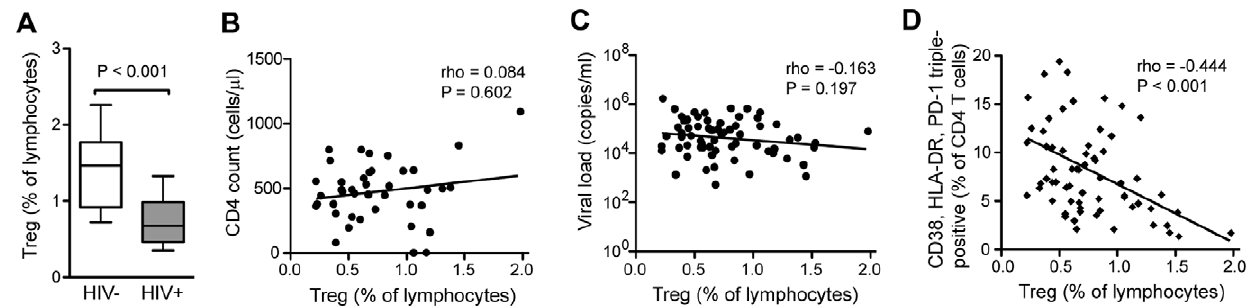
Figure 2. Inverse correlation between FoxP3 + regulatory T cells and PD-1 + CD38 + HLA-DR + CD4 T cells. (A) Box and whisker plots showing the median and 10–90 percentile percentage of FoxP3 + CD25 + CD127- regulatory CD4 T cells in HIV negative and HIV positive subjects. (B) Spearman rank correlation between regulatory CD4 T cells and CD4 absolute T cell counts. (C) Spearman rank correlation between regulatory CD4 T cells and viral load. (D) Spearman rank correlation between regulatory CD4 T cells and CD38, HLA-DR and PD-1 triple-positive CD4 T cells in blood.